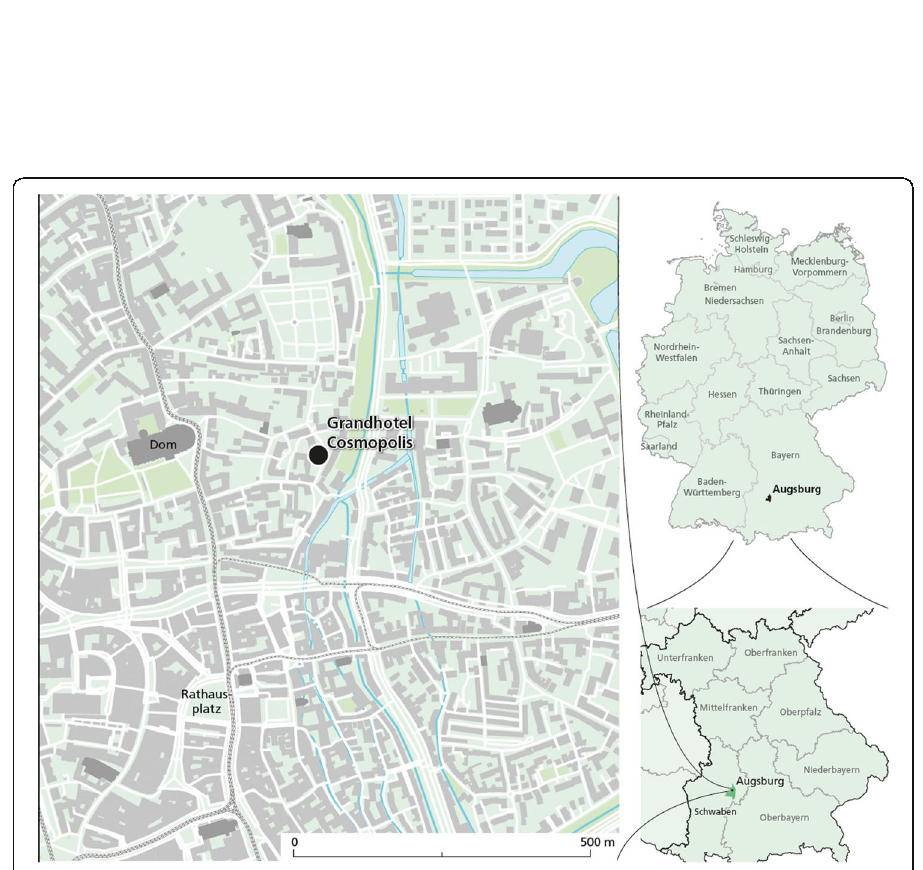
Fig. 3 Inner-city location of the GHC and Augsburg ’ s location in Bavaria and